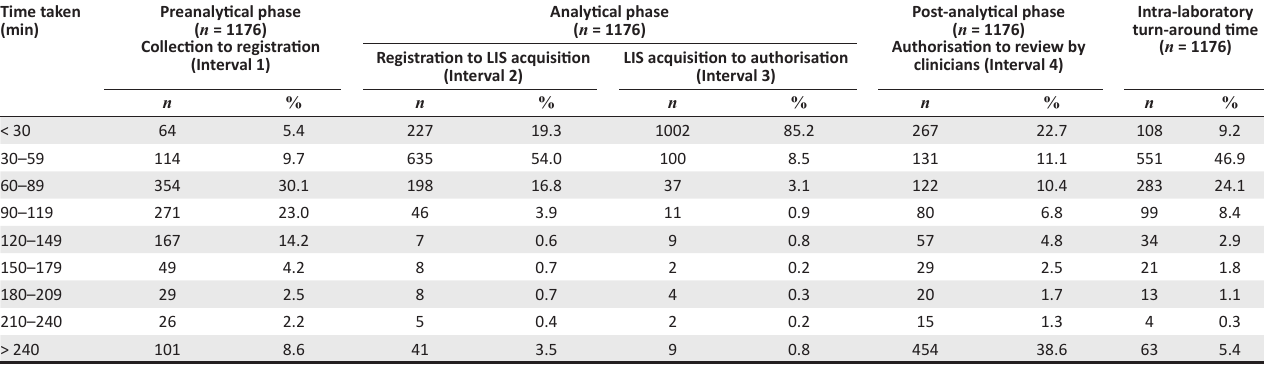
TABLE 1: Contribution of the different phases of sample processing to total turn-around time and intra-lab turn-around time. Time taken Preanalytical phase (min) ( n = 1176) Collection to